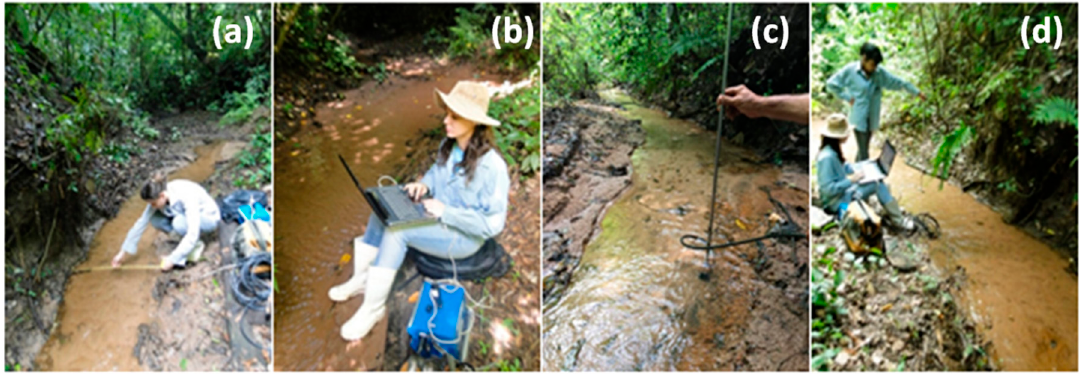
Figure 6. Flow data collection with the portable ISCO 2150 m: ( a ) width section measurement (cm) of a watercourse; ( b ) input parameters; ( c ) sensor in a watercourse; ( d ) reading flow and data storage.